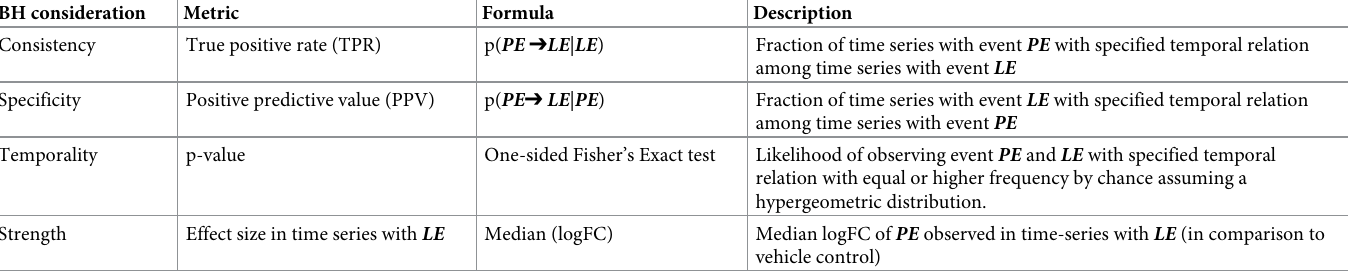
Table 1. Metrics quantifying the time concordance between a potential preceding event PE and potential later event LE , and their relation to the original Bradford Hill (BH)